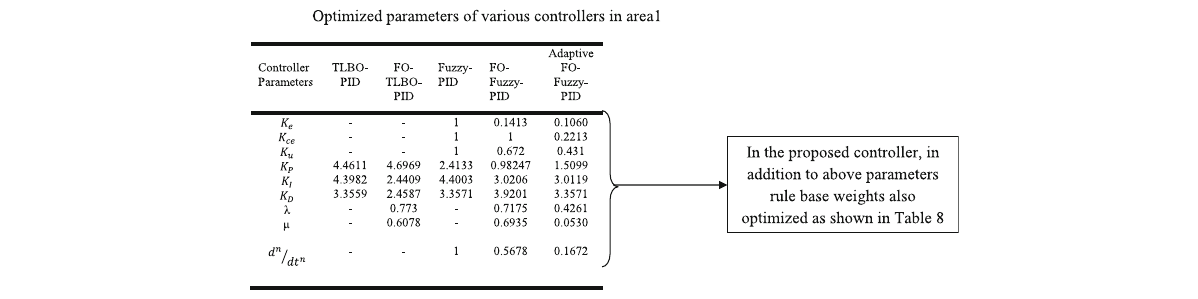
Table 7 Optimized parameters of various controllers in area1